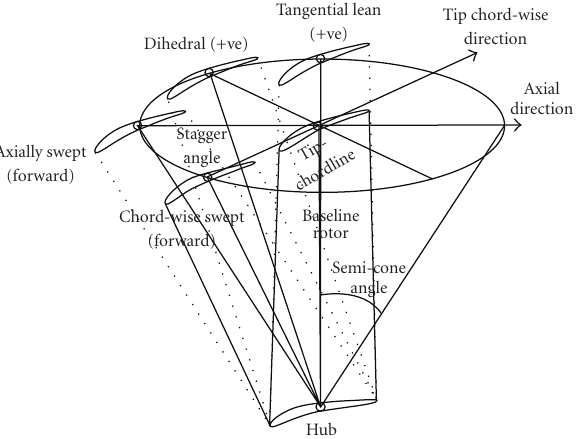
Figure 1: Definitions of various staking line modification schemes and conventions.